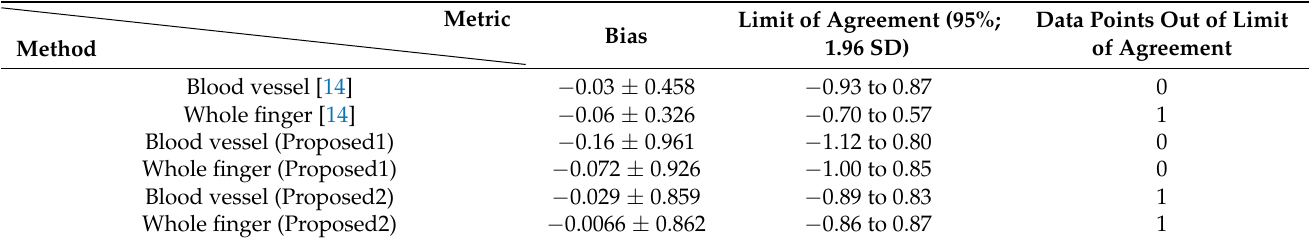
Table 6. Bland-Altman-analysis-based comparison between this study and the previous study for estimating HbA1c